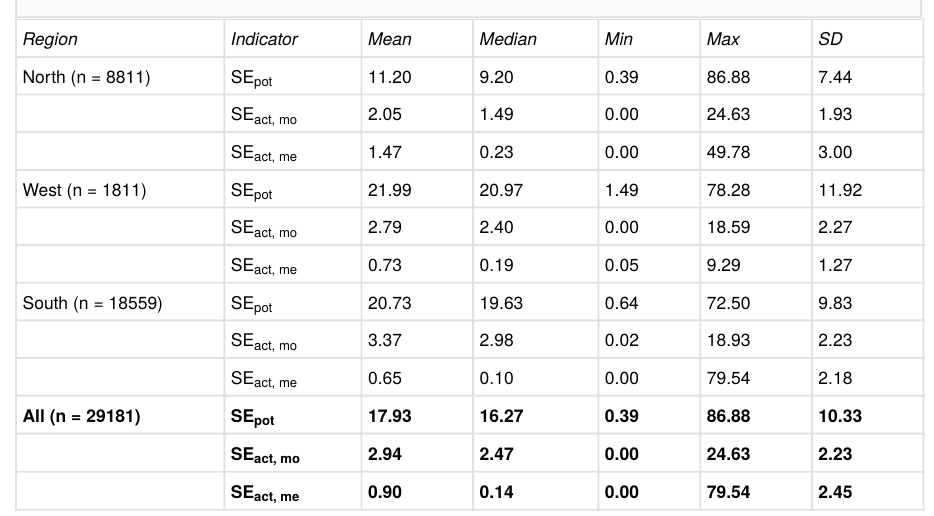
Table 5 summarises the value ranges and averages for the three indicators describing the structural and the mitigated structural impacts (SE , SE , SE ), grouped by region. Additionally, Fig. 4 presents two exemplary maps for the three indicators. The mean SE for the whole study area (18.41 t ha a ) is signi fi cantly higher than the mean for the northern region (12.97 t ha a ). The highest single value for SE with 92.07 t ha a was modelled for a raster cell in the northern region. Average highest values were modelled for the southern region (20.83 t ha a ), whereas the western region shows a slightly lower potential soil loss risk (20.07 t ha a ). Table 5. Statistical values for the indicators describing the potential and actual soil loss (SE , SE and SE ), grouped by regions [t ha a ] (n = 29181, number of raster